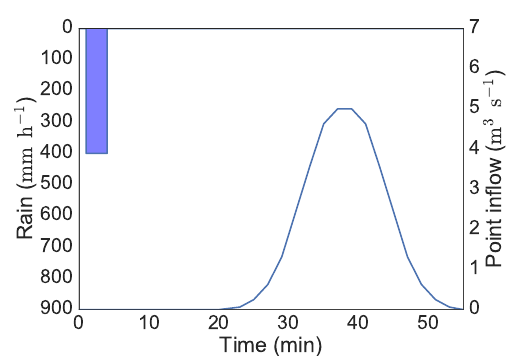
Figure 5. Rectangular hyetograph and point inflow hydrograph for the EA test 8a. Table 1. Simulation parameters for the EA test case